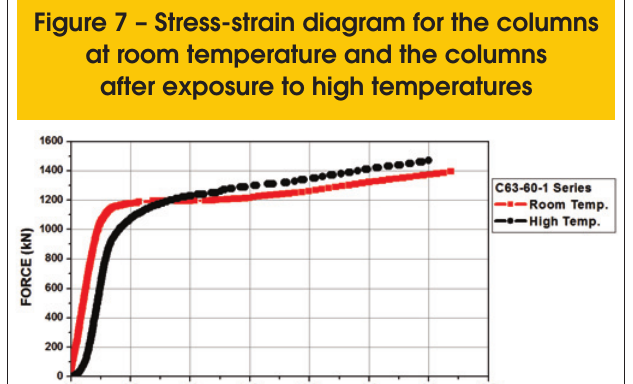
Figure 8 – Temperature vs. time curves in the steel with a 30-minute exposure time